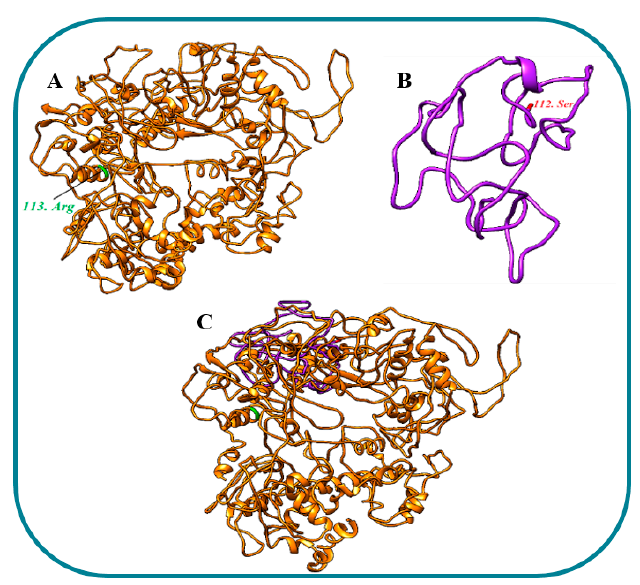
Figure 7. Three-dimensional structural presentations of GLI1 predicted by I-TASSER ( A ) Wildtype GLI1 ( B ) Mutant KIAA0825 ( C ) Superimposed wildtype and mutant GLI1.